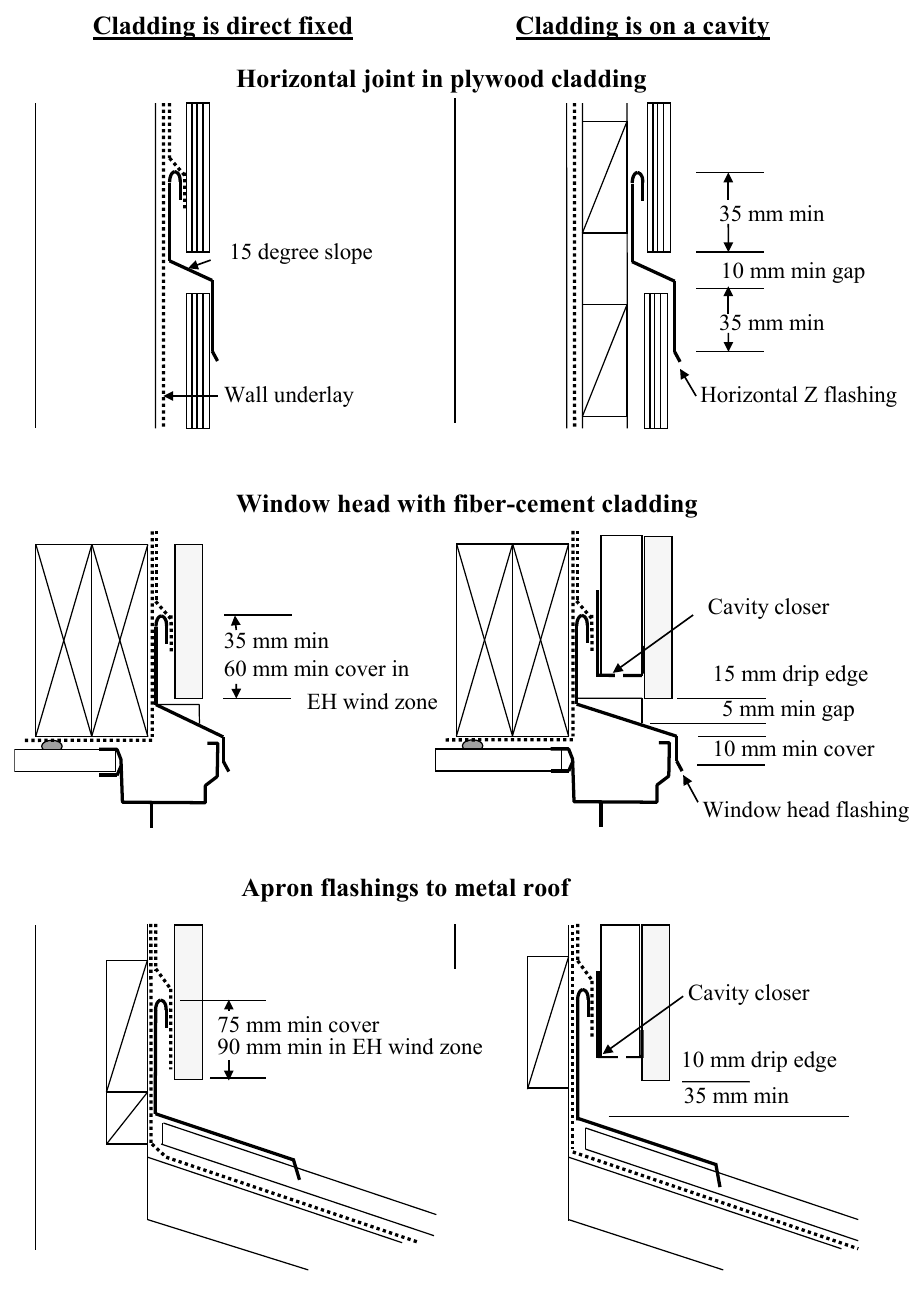
Figure 3. A selection of flashings used in NZ buildings and taken from